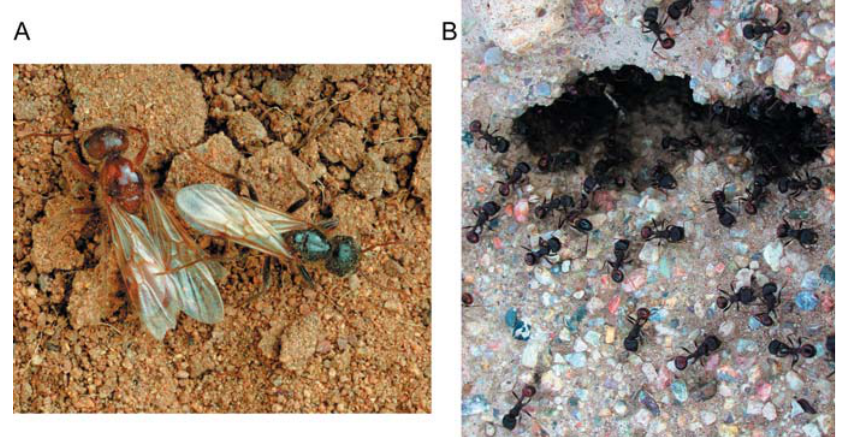
Figure 3. An Ant with Three Sexes? (A) Two males from the harvester ant genus Pogonomyrmex , one from each genetic strain. In a recently discovered hybrid system, queens must mate with both types of males to produce reproductives and workers. Photo courtesy of Charles Hedgcock, Charles Hedgcock Photography, Tucson, Arizona, United States. (B) Hybrid workers emerging from a nest. Photo courtesy of Veronica Volny, University of California, Berkeley, California, United